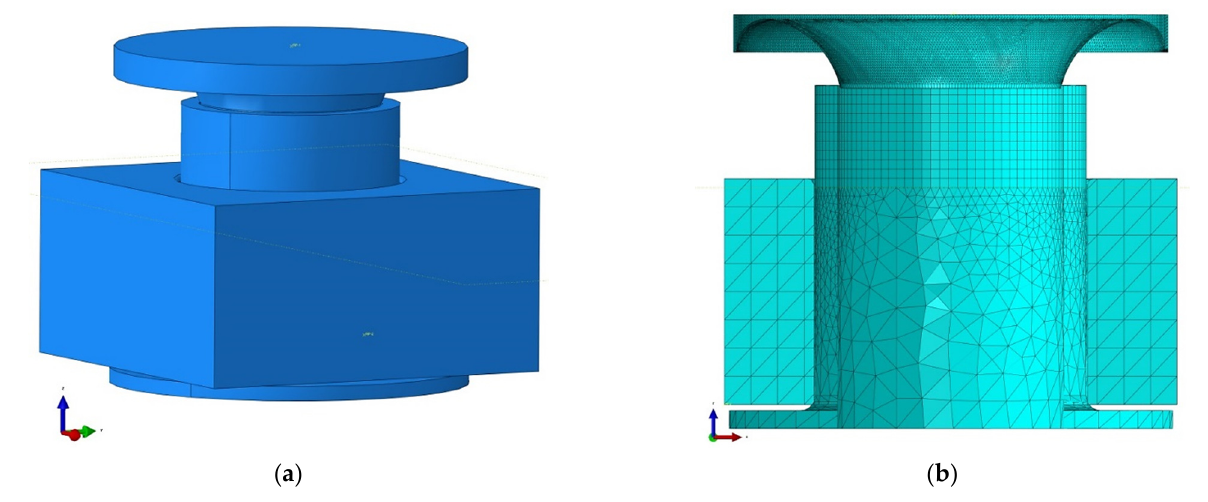
Figure 3. FE model assembly stage ( a ) view of the instance model, ( b ) cross ‐ section with visible finite element meshes.